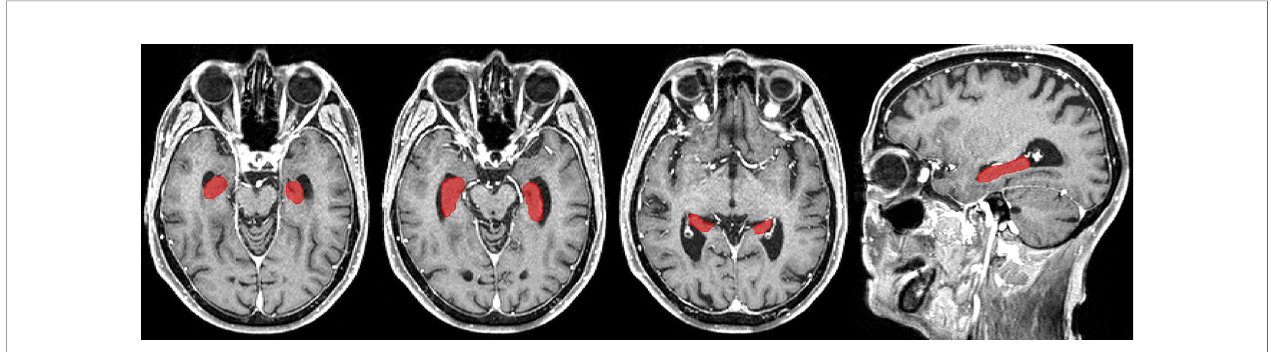
FIGURE 2 | Example of a hippocampus segmentation on CE-T1-MR imaging using the CAT and the in vivo high-resolution CoBrA atlas of the hippocampus